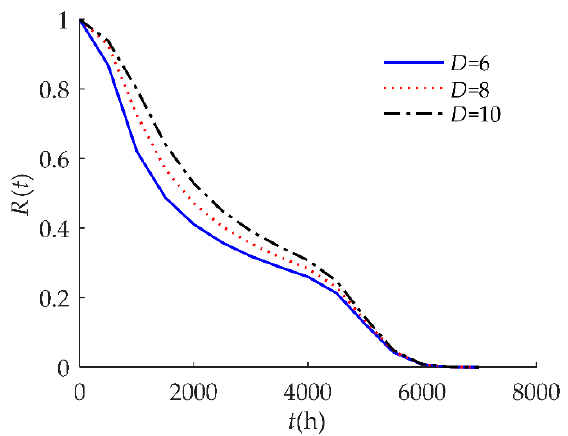
Figure 5. Sensitivity analysis of R ( t ) on D for example I.